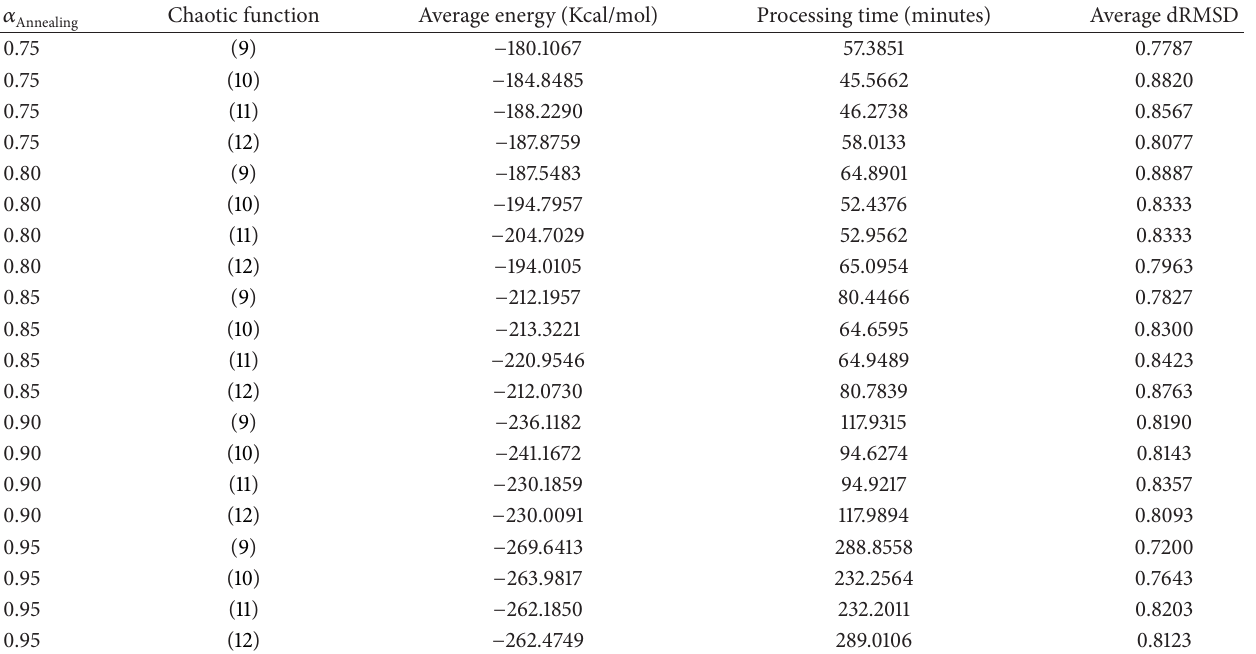
Table 4: Average results of T0549 instance.